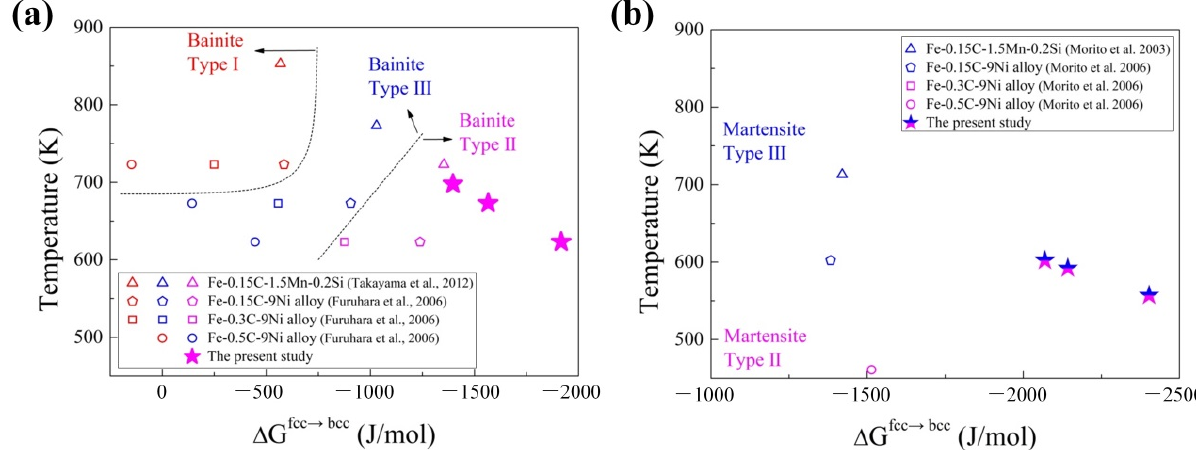
Figure 9. Effect of the driving forces for ( a ) bainite and ( b ) martensite transformation on the crystallographic characteristics. [5–8] The marks representing variant pairing type are colored as follows: red, type I; magenta, type II; blue, type III; upper blue and lower magenta, type II dominated with occasional type III.